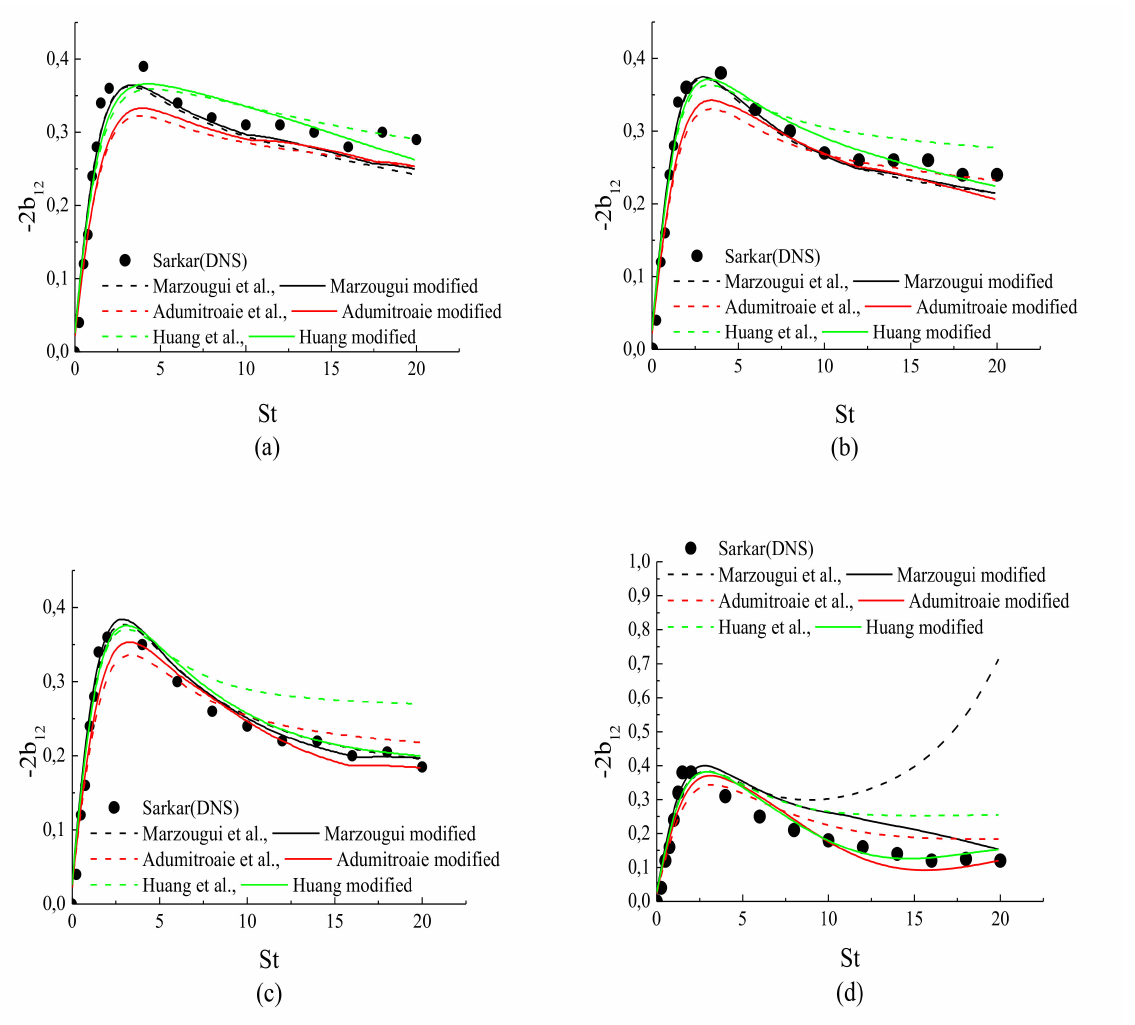
Figure 4. Time evolution of the shear Reynolds stress anisotropy, b 12 , in the following cases: ( a )